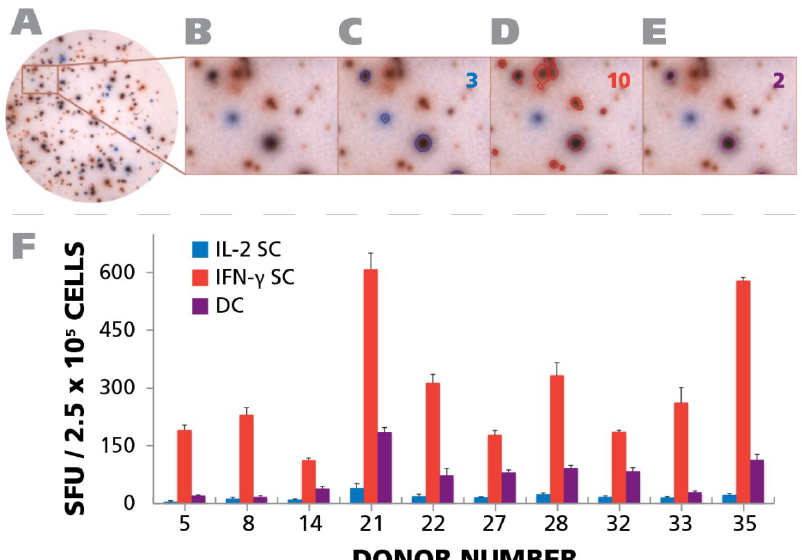
Figure 8. Detection of polyfunctional CD4 cells. PBMC from 10 donors (IDs are specified in the figure) were subject to an IFN-γ/IL-2 Dual color ELISPOT assay at 250,000 cells per well, upon activation with 50 μg/mL of HCMV antigen. PBMC donor IDs were selected based on the response observed in Figure 4A. ( A ) A representative well image with both IFN-γ and IL-2 response is shown; ( B ) A digitally magnified portion of the representative well is shown; ( C ) Blue colored SFU representing IL-2 response are overlaid with a blue circle. The number of IL-2 SFU is inset in the figure; ( D ) Red colored SFU representing IFN-γ response are overlaid with a red circle. The number of IFN-γ response is inset in the figure; ( E ) Responses that are positive for both IL-2 and IFN-γ are shown as SFU that are both blue and red, and are visually represented by a purple color. The number of polyfunctional, i.e. , positive for both, responses is inset in the figure; ( F ) The mean recall response for IFN-γ, IL-2, and polyfunctional responses for the individual donors and their respective SD from three representative wells is shown.